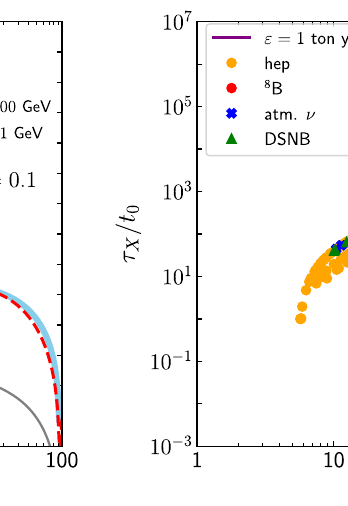
neutrino source (best fits) shown by the points as labeled and determin- ing the shape of the discovery limit for threshold E R exposure of (cid:19) = 1